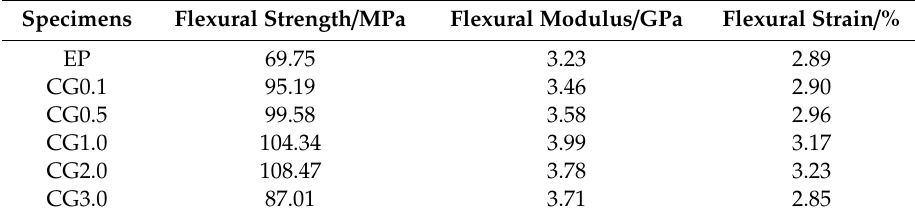
Table 2. Flexural properties of the AMGNS-MWCNT/epoxy nanocomposites with different AMGNS-MWCNT content.